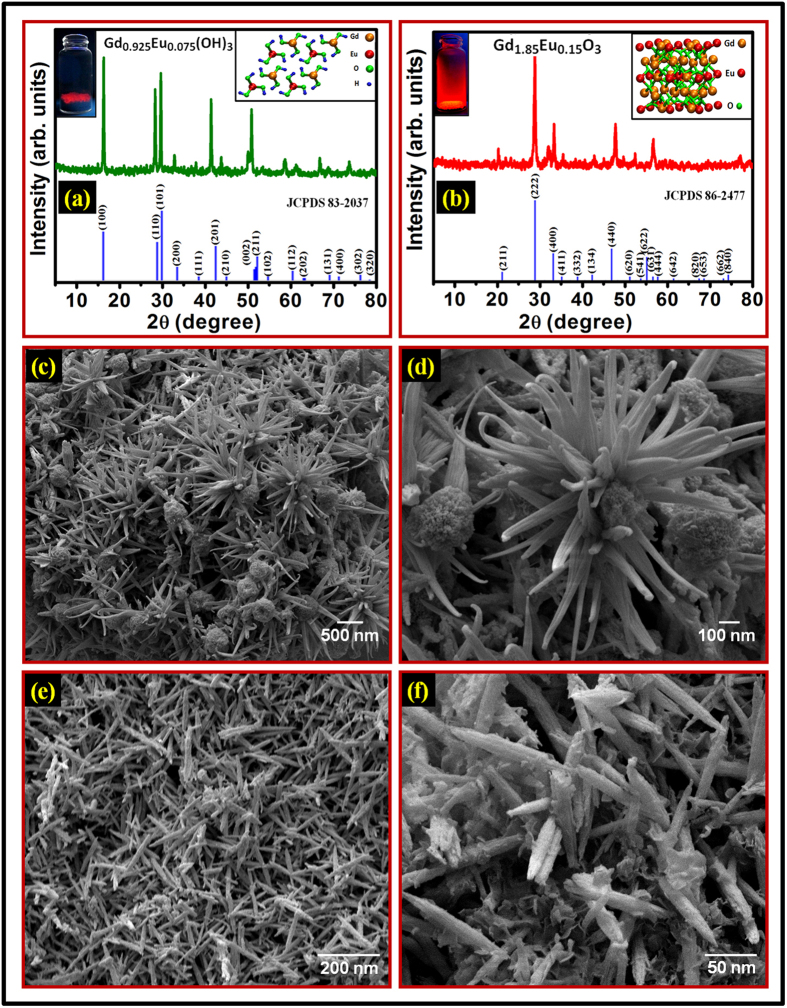
(a) XRD pattern of as-synthesized Gd0.925Eu0.075(OH)3 nanophosphor; left inset represents the as-synthesized luminescent powder sample under excitation of 254 nm and right inset exhibits the structure of Gd0.925Eu0.075(OH)3 nanophosphor. (b) XRD pattern of as-synthesized Gd1.85Eu0.15O3 nanorods; left inset represents the as-synthesized luminescent powder sample under excitation of 254 nm and right inset exhibits the structure of Gd1.85Eu0.15O3 nanorods. (c) SEM image of as-synthesized Gd0.925Eu0.075(OH)3 nanophosphor. (d) Magnified view of Fig. c. (e) SEM image of as-synthesized Gd1.85Eu0.15O3 nanorods. (f) Magnified view of Fig. e.